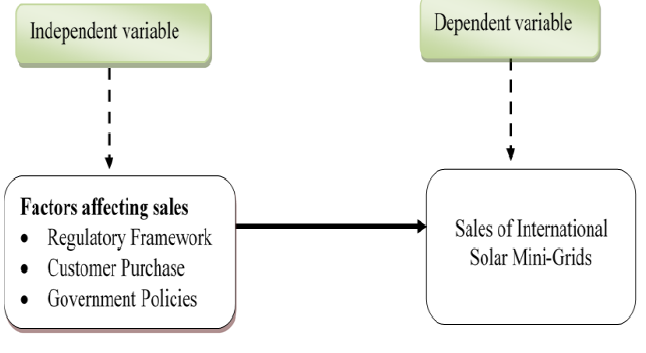
Figure 1: The conceptual Framework; Source: Literature Review